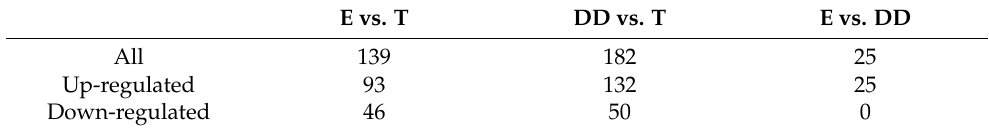
Table 2. The number of up- and down-regulated differentially expressed lncRNAs in three comparisons. E vs. T DD vs. T E vs. DD All 139